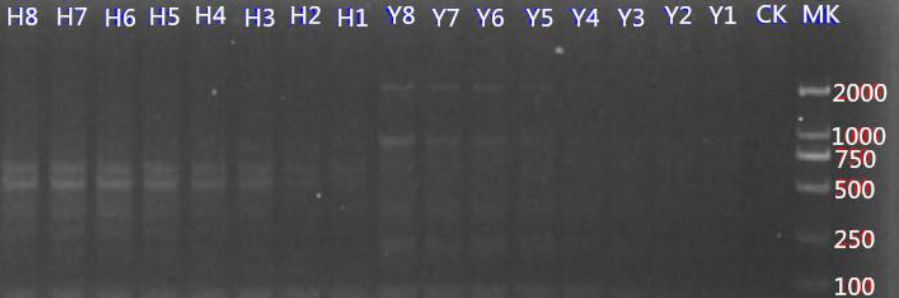
Figure 9. Agarose gel electrophoresis map of the coxL gene PCR product.